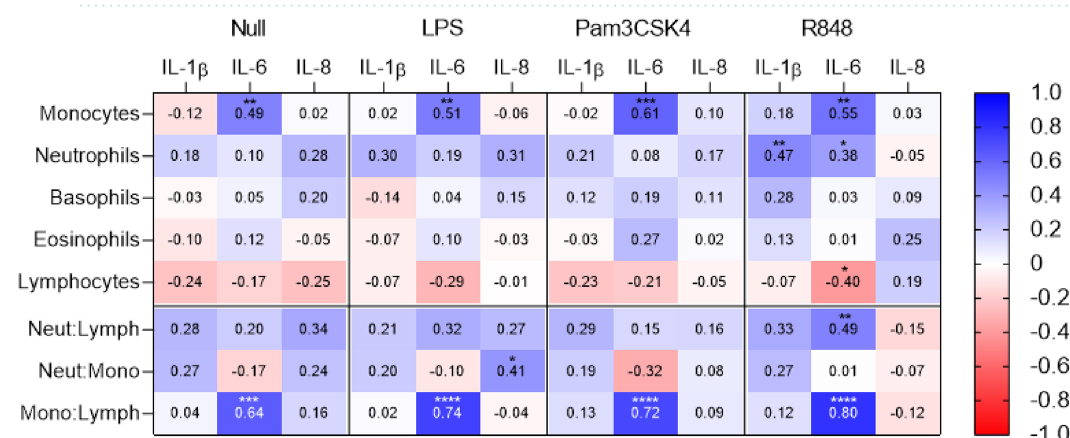
Figure 5. Correlation analysis of cytokine and chemokine responses to multiple PAMPs. Pearson’s correlation coefficient matrices, represented as a heatmap, calculated for ( A ) IL-1β, ( B ) IL-6 and ( C ) IL-8 between responses to null, 2 µg/mL of LPS, 1 µg/mL of Pam3CSK4, 0.2 µg/mL of R848 responses for ten animals across three timepoints. Results were graphed using Prism software (v9.1) (www. graph pad. com).